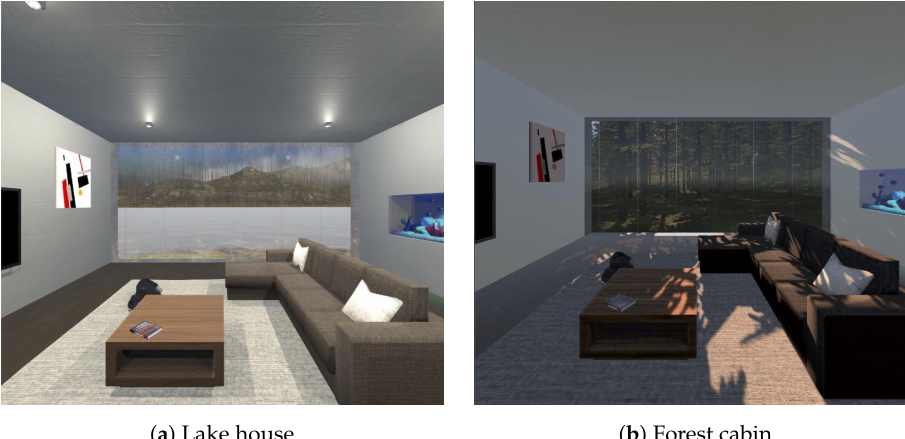
Figure 4. The two types of indoor